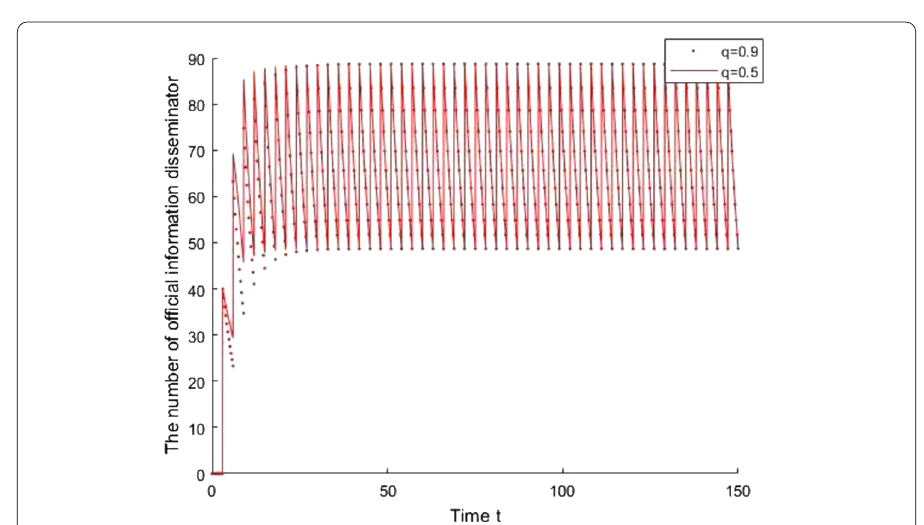
Figure 9 When q > q thr , the evolution graph with different q of y ( t ) are in